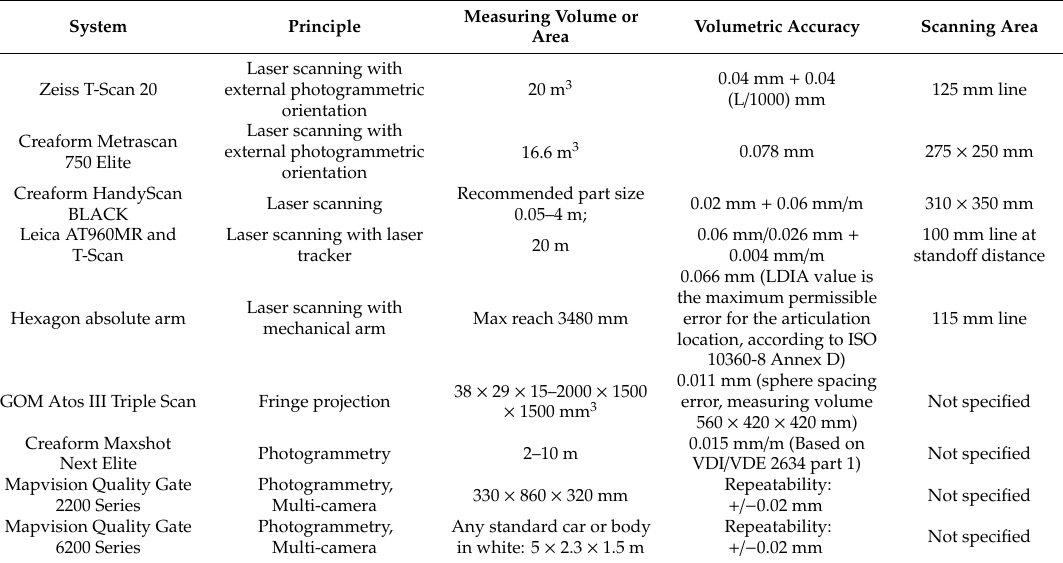
Table 3. Optical measuring systems: characteristics and operating